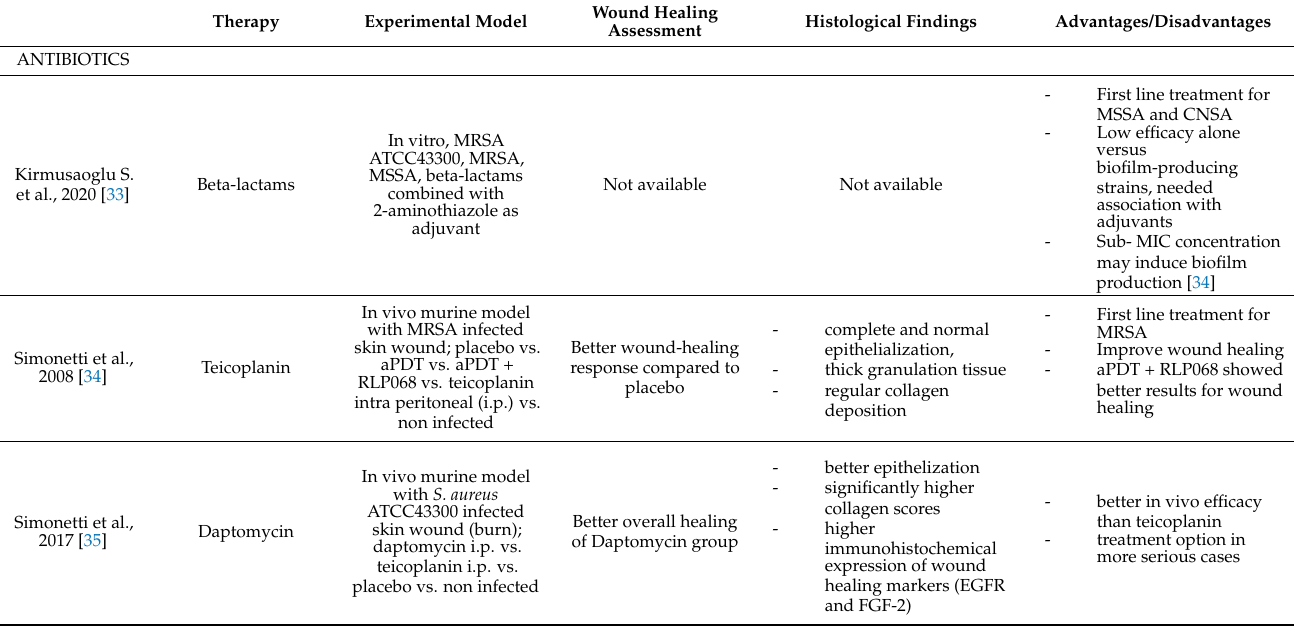
Table 1. Summary of reviewed